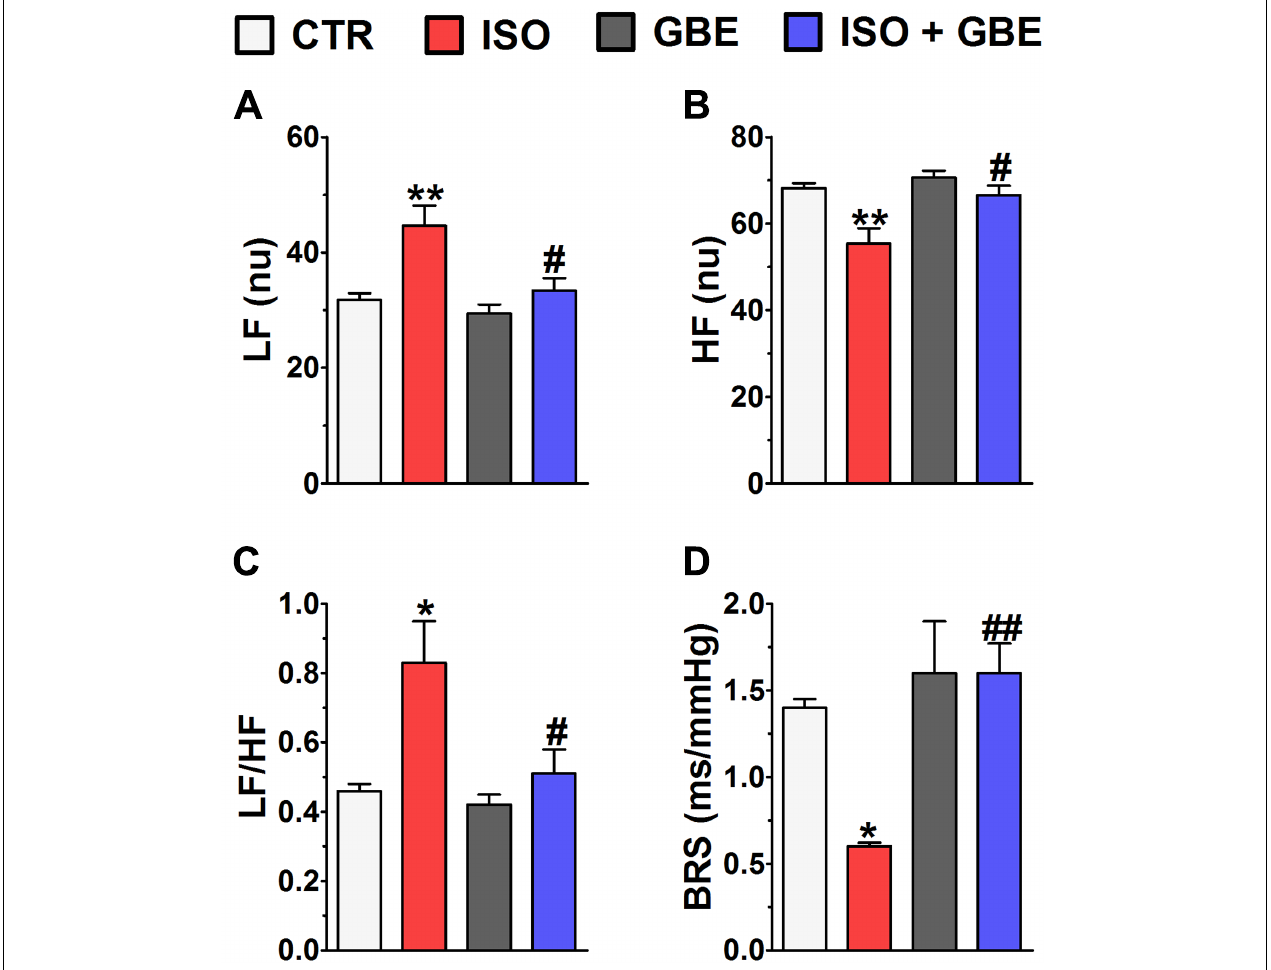
FIGURE 1 | Ginkgo biloba extract restores the impaired cardiovascular autonomic modulation and baroreflex sensitivity of hypertrophic hearts. (A) low frequency band (LF), (B) high frequency band (HF), (C) LF/HF ratio, and (D) baroreceptor reflex sensitivity (BRS). Data are represented as means ± SEM, ( n = 5). ∗ p < 0.05 and ∗∗ p < 0.01 vs. CTR, # p < 0.05 and ## p < 0.01 vs. ISO, one-way ANOVA followed by Bonferroni’s post-test.